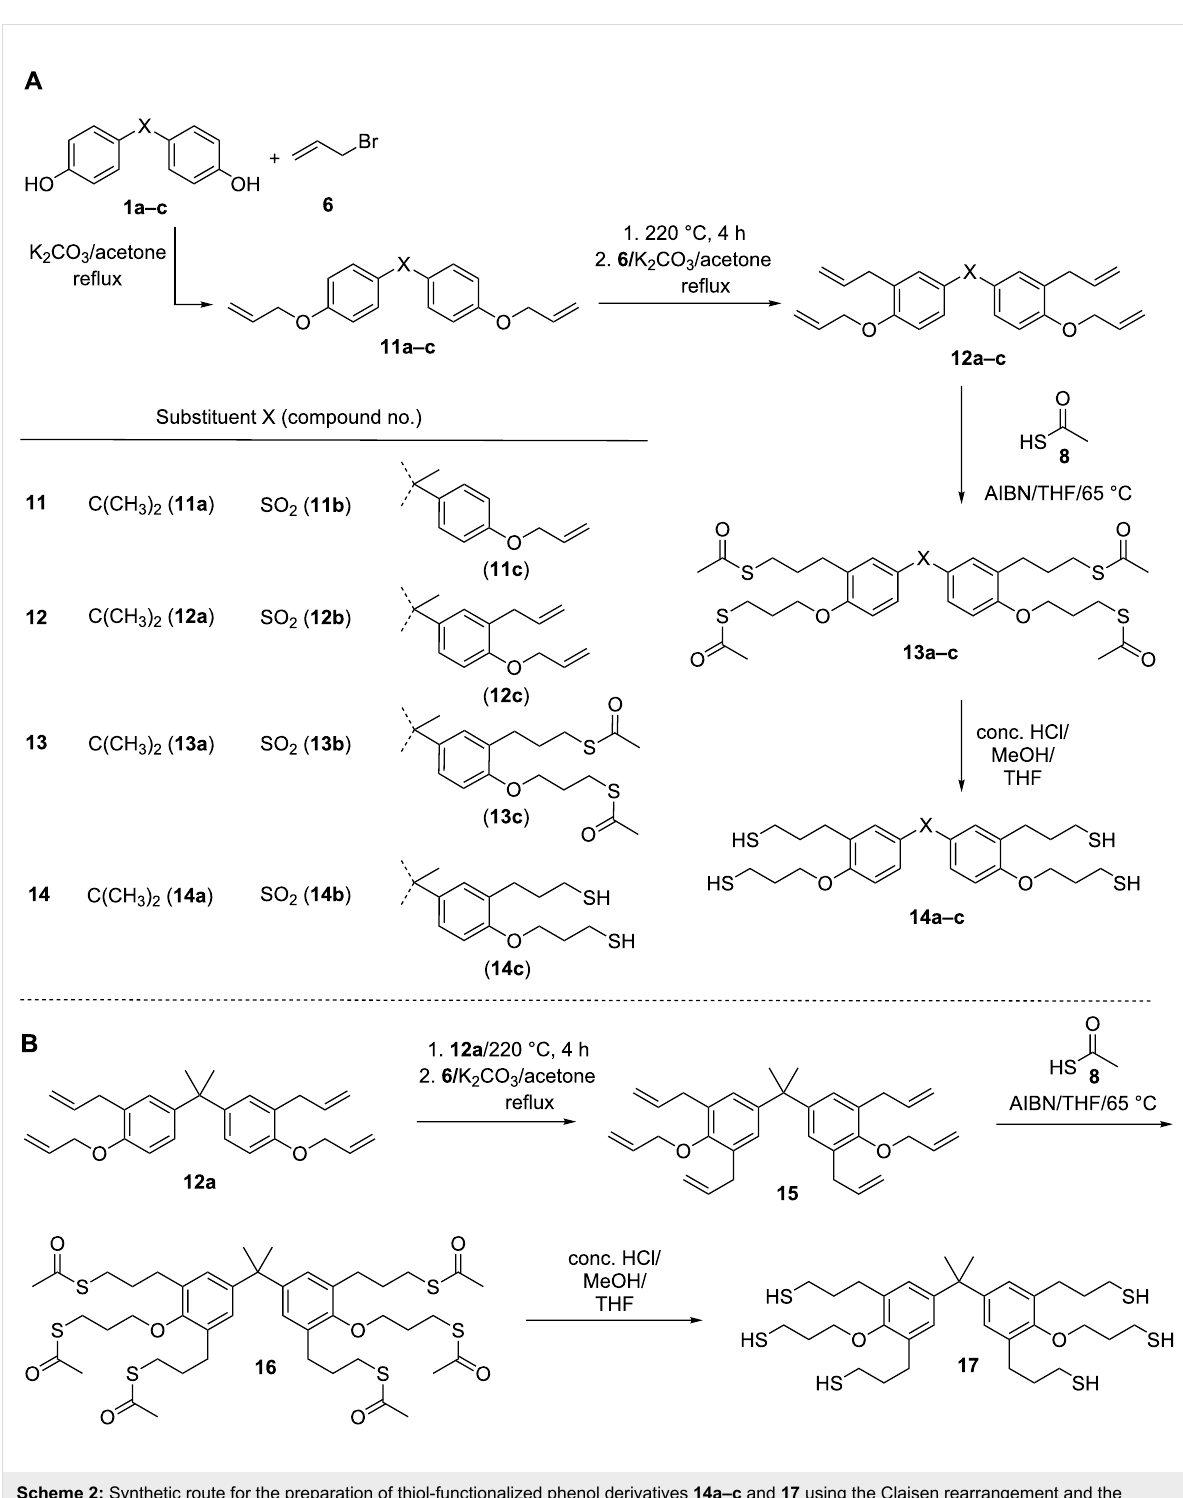
PETMP containing sample decreased by 50% to a value of 47.8 MPa. Similar results were found for the modulus of elas- ticity: the PETMP sample showed a decrease from 3.2 GPa to